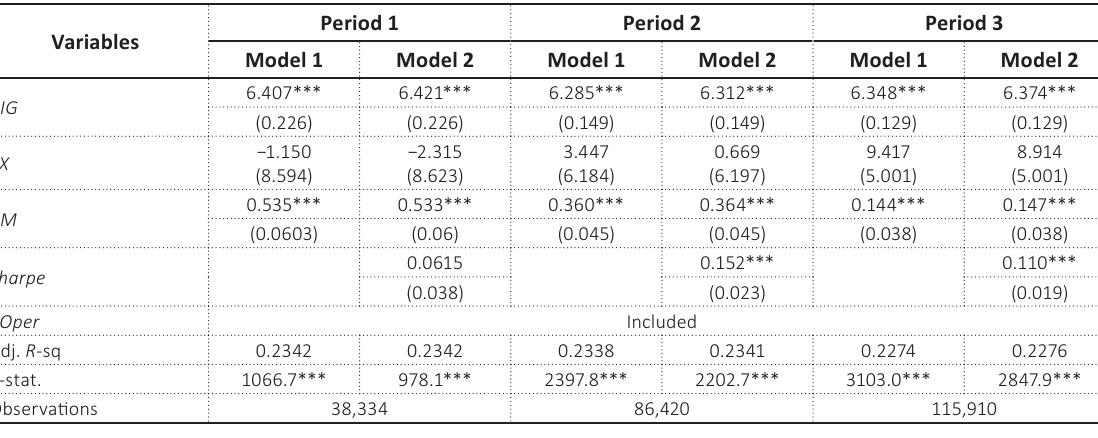
Table 7 (cont.). Regression results: RSTA